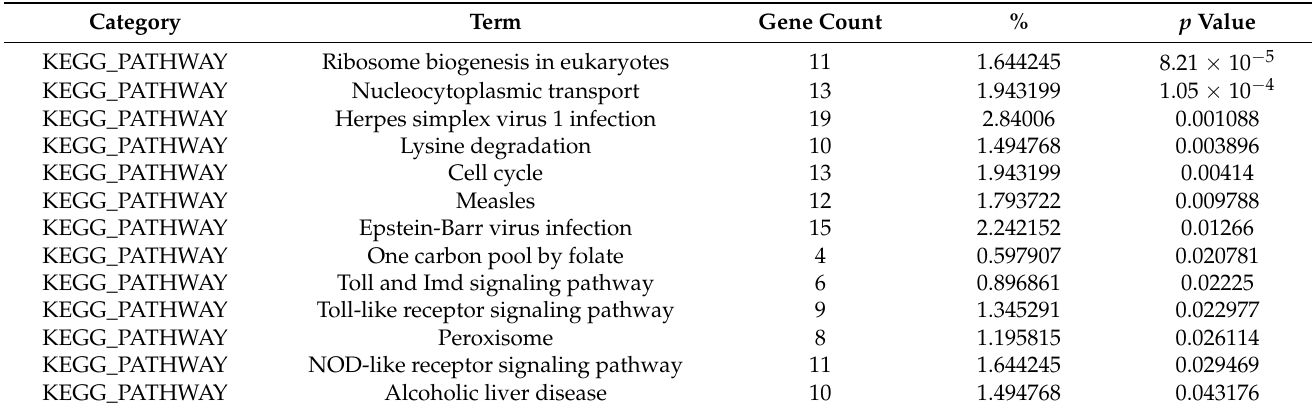
Table 2. Pathways affected by E. ictaluri effector T3SS EseN.